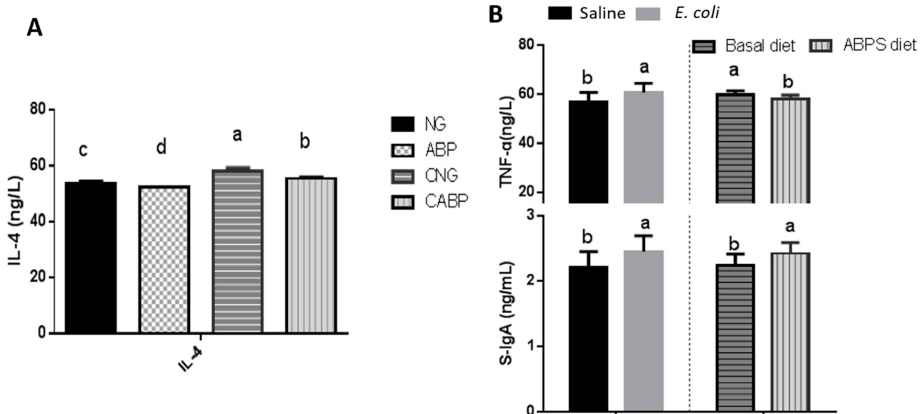
Figure 1. Effects of ABPS and E. coli challenge on mucosal cytokines and S-IgA in yellow-feathered broilers. ( A ) Concentration of IL-4 in jejunal mucosa; the interaction effect between E. coli challenge and ABPS was observed for IL-4 throughout the trial period. ( B ) Concentrations of TNF- α and S-IgA in jejunal mucosa; ABPS and E. coli treatments were significant ( p < 0.05) for TNF- α and S-IgA. Values are means ± SE, n = 6. Different superscripted lowercase letters within each group mean the values differ significantly ( p < 0.05). NG: basal diet; ABP: supplemented with 500 mg ABPS additive per kg of diet; CNG: basal diet group with E. coli challenge; CABP: ABP group with E. coli challenge.